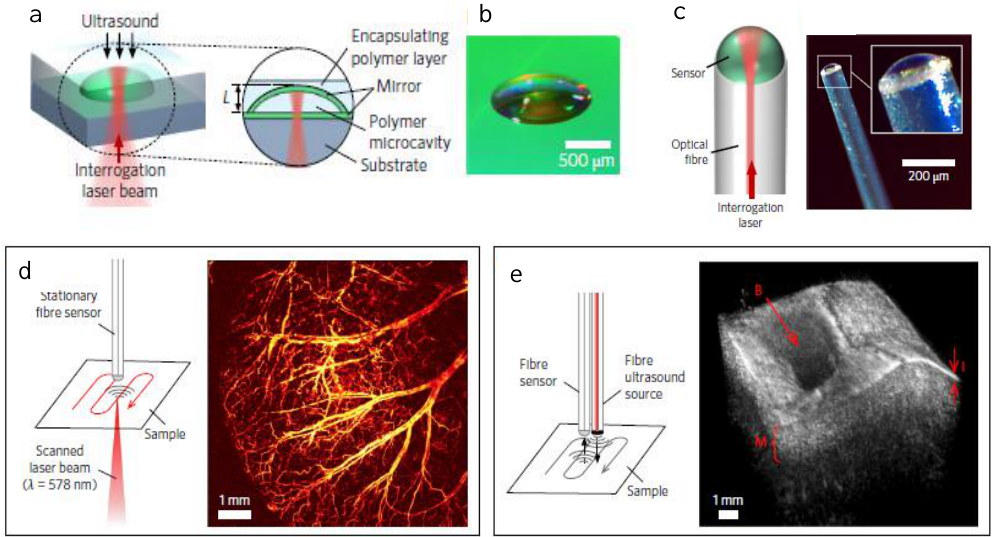
Figure 13. ( a ) Schematic of the plano-concave optical microresonator. ( b ) Photograph of polymer microcavity prior to the application of the encapsulating polymer layer. ( c ) Schematic diagram (left) and photograph (right) of the optical fiber microresonator sensor. ( d ) Schematic diagram of a fiber microresonator sensor-based optical-resolution photoacoustic microscopy experiment and an image of mouse ear vasculature in vivo. ( e ) Schematic diagram of the all-fiber pulse-echo ultrasound experiment and 3D pulse-echo ultrasound image of an ex vivo porcine aorta. Reproduced with permission from Macmillan Publishers Ltd. [92]. Copyright 2017.